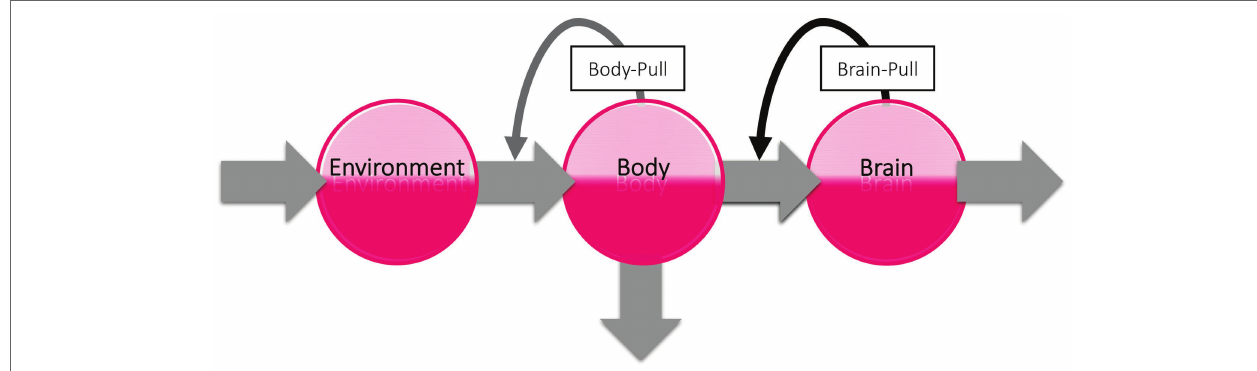
FIGURE 5 | The cerebral supply chain. Energy is transferred from the environment through the body to the brain, the end consumer of the supply chain. When the brain needs energy, the brain-pull demands it from the body. When the body needs energy, the body-pull demands it from the